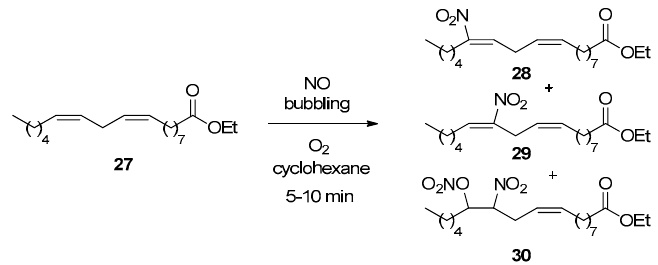
Scheme 4. Synthesis of nitro derivatives of ethyl